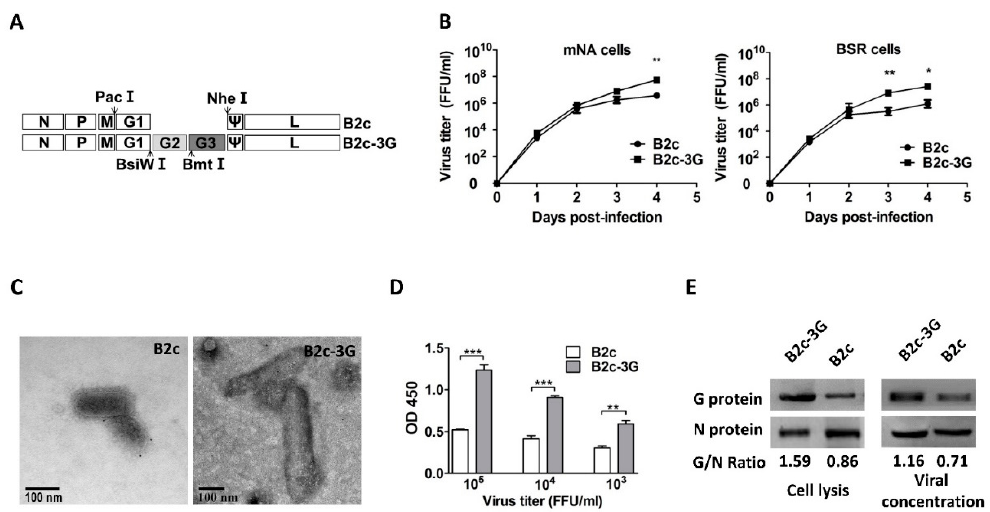
Figure 2. Construction and in vitro characterization of B2c-3G, a recombinant RABV expressing three copies of G. ( A ) Schematic diagram of B2c recombinant virus carrying two extra G genes, each with its own reading frame. The arrows indicate the location of restriction enzyme sites in the genome of RABV. ( B ) Growth curves of B2c-3G and B2c were generated in NA and BSR cells. ( C ) Morphological analysis and length of B2c-3G and B2c were compared by electron microscopy after negative staining. ( D ) ELISA of G content in RABVs at 10 3 , 10 4 , and 10 5 FFU/ml. ( E ) Western blot analysis of viral protein in NA cells and viral protein incorporated into virions. The ratio between G and N was calculated from the intensity of the band using Image-Pro Plus 6.0. The significance of differences between viral titers or OD450 of B2c-3G and B2c were assessed by the unpaired t -test. *, p < 0.05; **, p < 0.01; ***, p < 0.001.